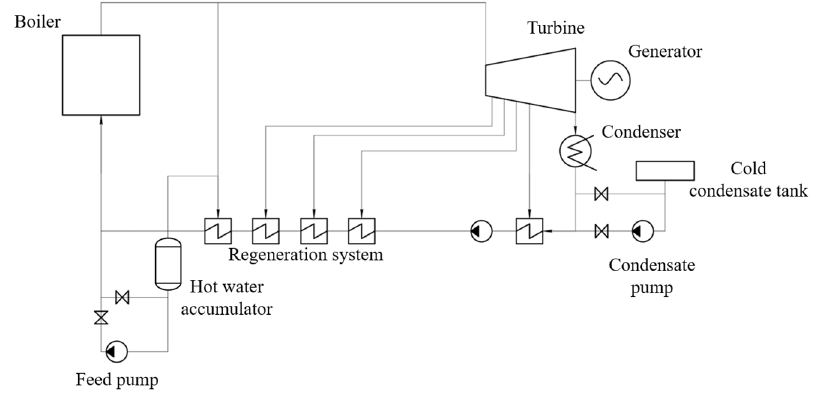
Figure 11. Heat flow chart of TPP with feed water accumulator .